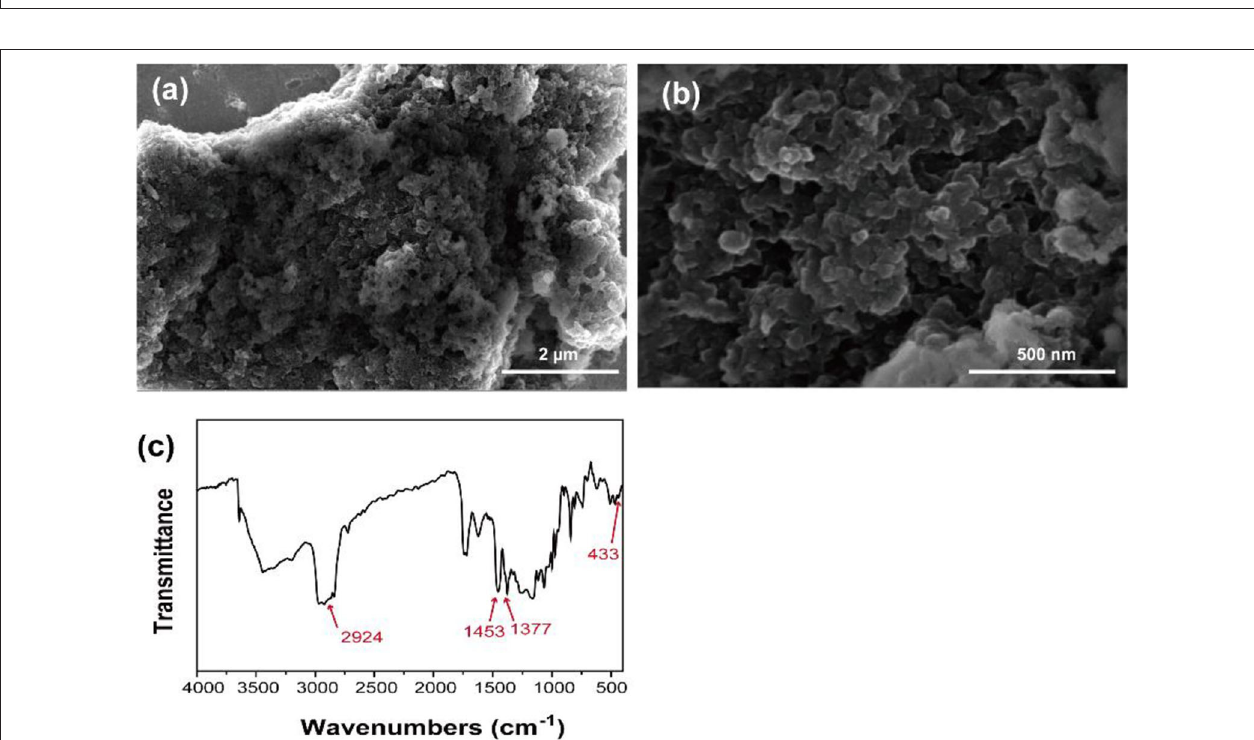
FIGURE 2 | (a,b) SEM image with different magnification, (c) FTIR spectra of